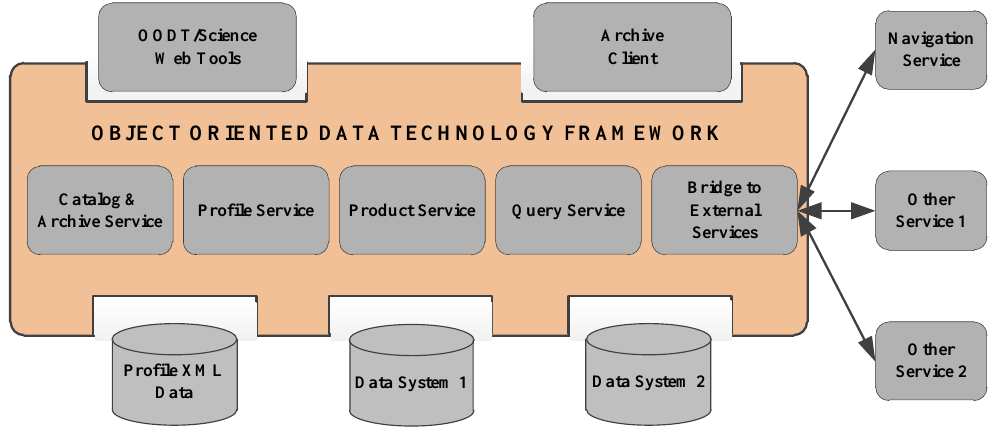
Figure 1. An object-oriented data technology (OODT)